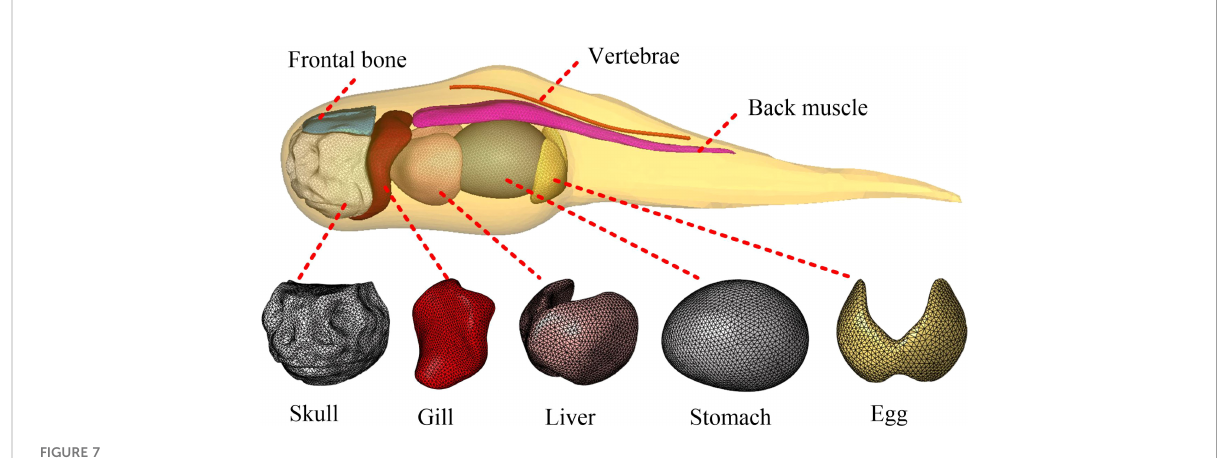
FIGURE 7 Finite element model of hadal snail fi sh.